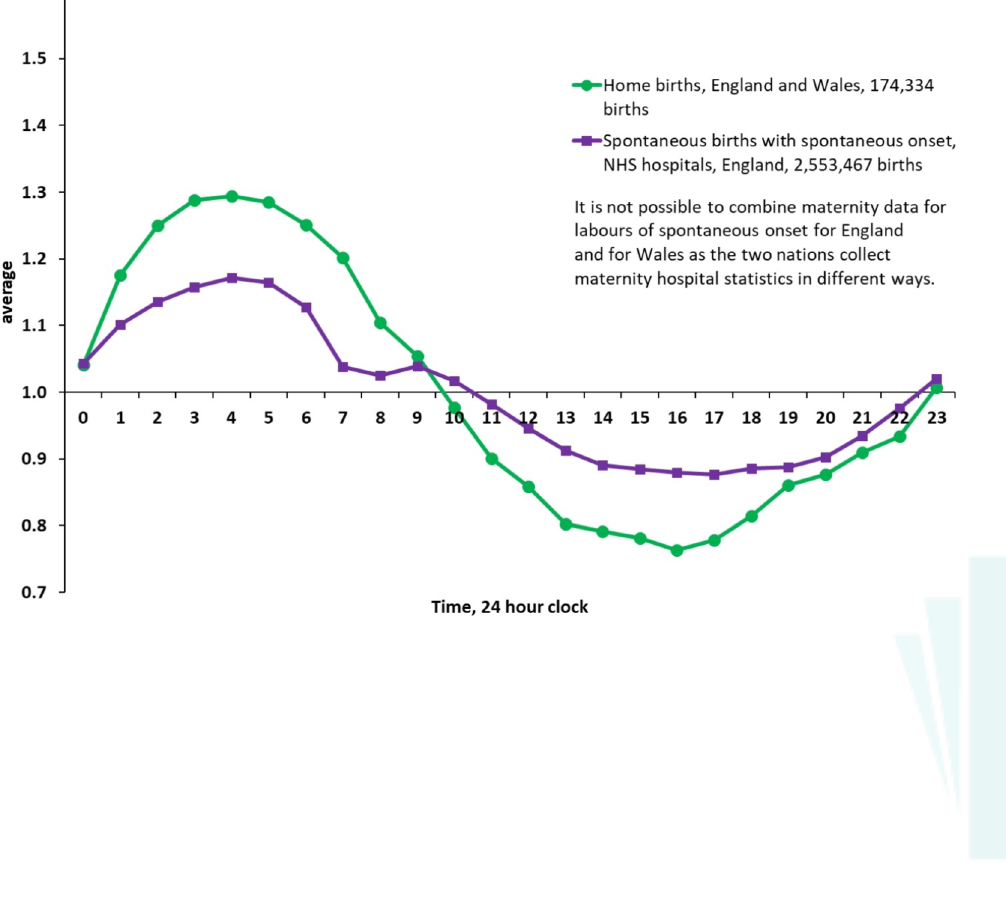
Figure 3: Variations in singleton births by time of day, spontaneous births with spontaneous onset in NHS maternity units in England (all three settings combined) and births at home in England and Wales,